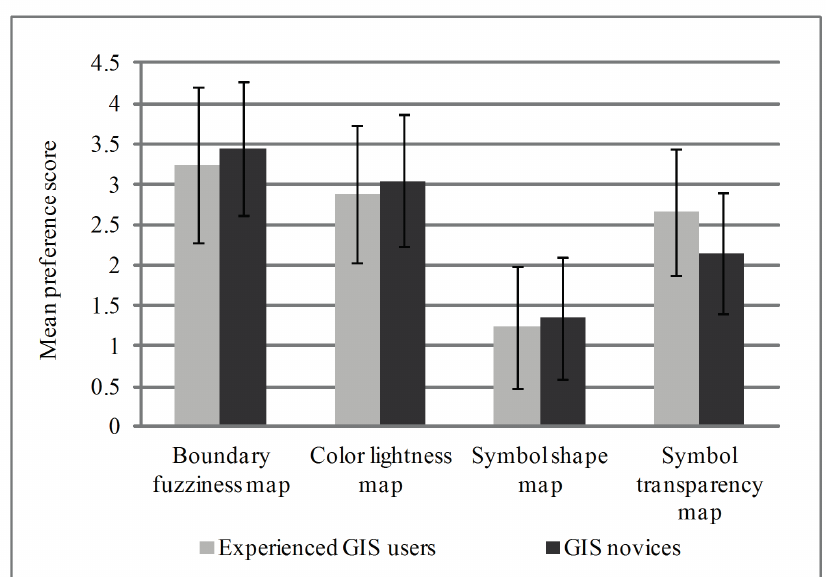
Figure 2. The mean and standard deviation of preference scores of the four visual variables in representing